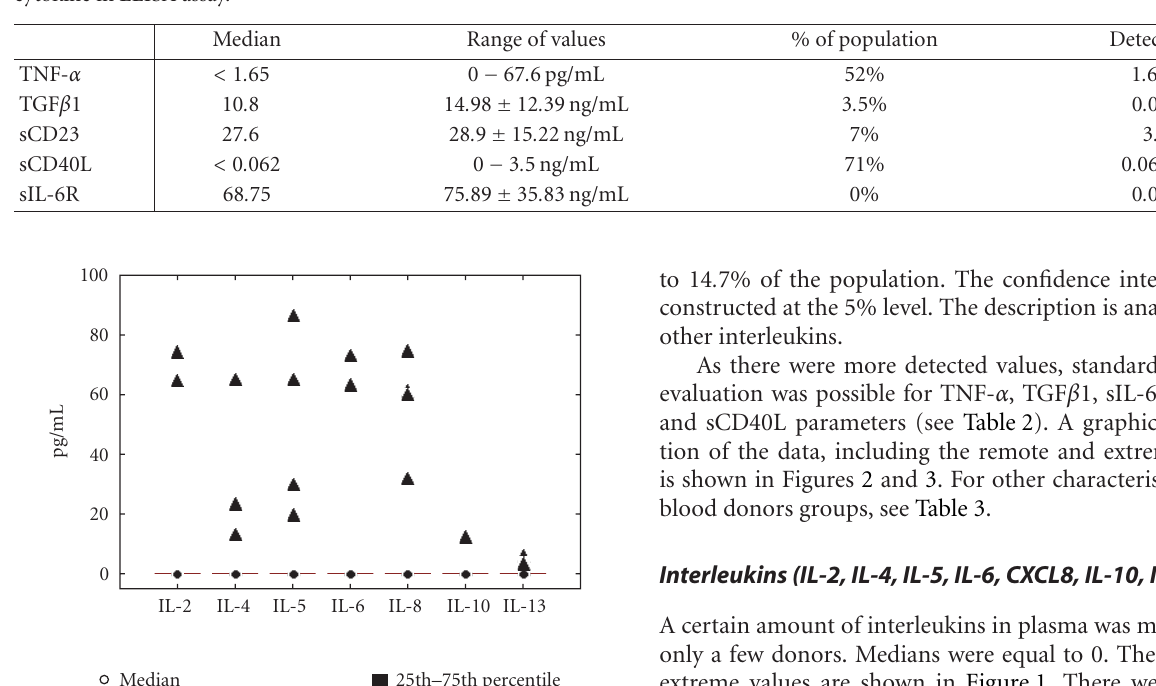
Table 2: Medians and ranges of measured values of cytokines and costimulatory molecules (except interleukins). Percentage of population describes proportion of blood donors with nondetectable level of particular cytokine. Detection limit shows limit for detecting particular cytokine in ELISA assay.